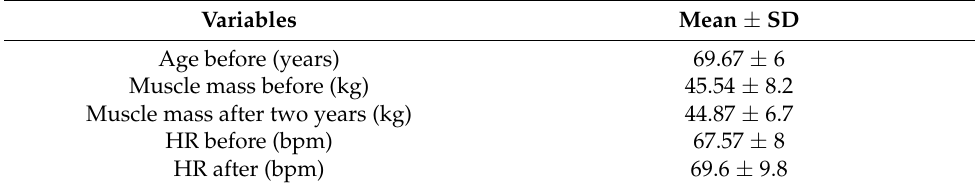
Table 1. Quantitative variables included in linear mixed model.